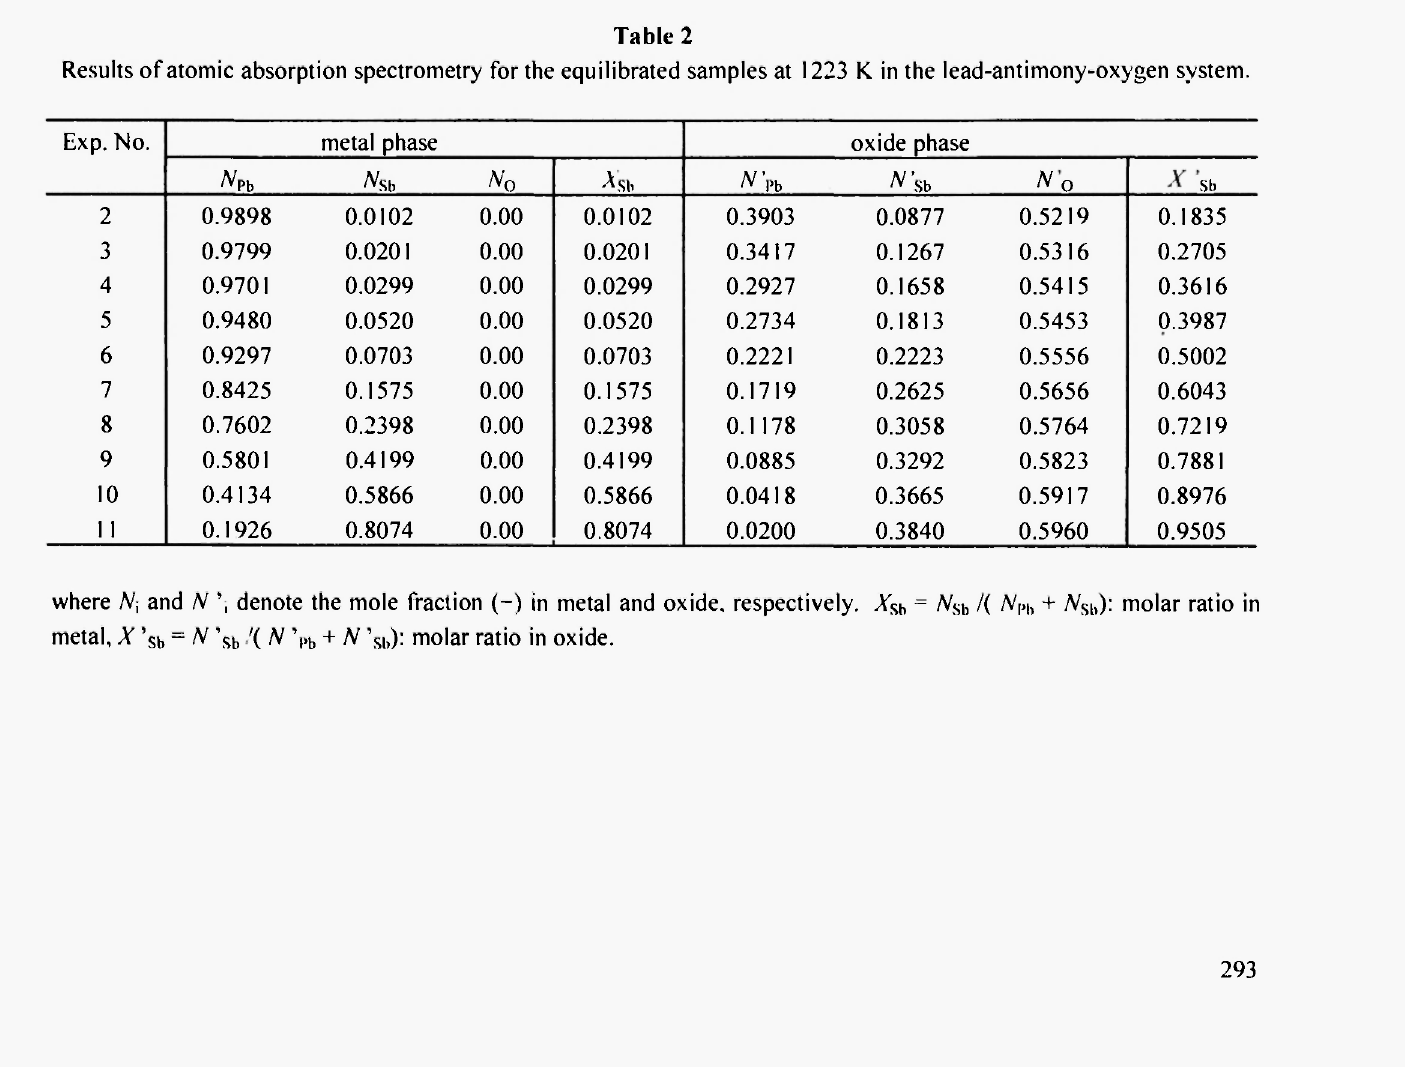
Results of atomic absorption spectrometry for the equilibrated samples at 1223 Κ in the lead-antimony-oxygen system. Exp.